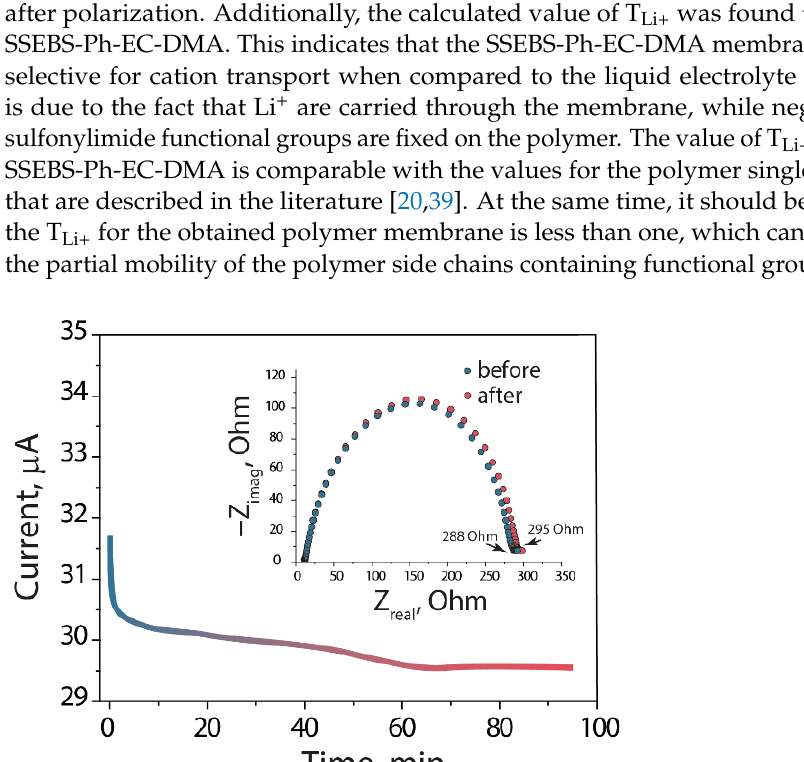
Figure 5. The chronoamperometry curve at a potential of 0.01 V and impedance spectra before and after polarization with DC of the Li|SSEBS-Ph-EC-DMA|Li cell.